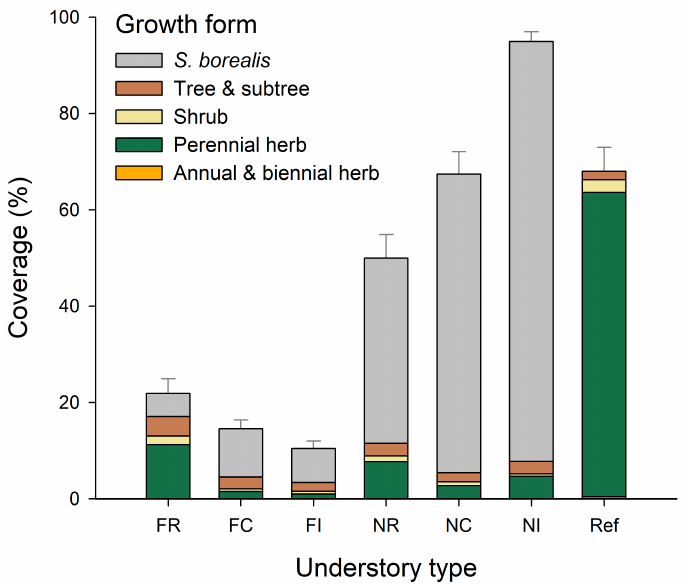
Figure 5. Vegetation coverage in the stands with seven understory types measured in 2020. The values are average ± standard error. FR: flowering and rooting, FC: flowering and cutting, FI: flowering and intactness, NR: non-flowering and rooting, NC: non-flowering and cutting, NI: non-flowering and intactness, Ref: reference. Table 3. Repeated measures analysis of variance for the effects of flowering, rooting, and cutting on tree